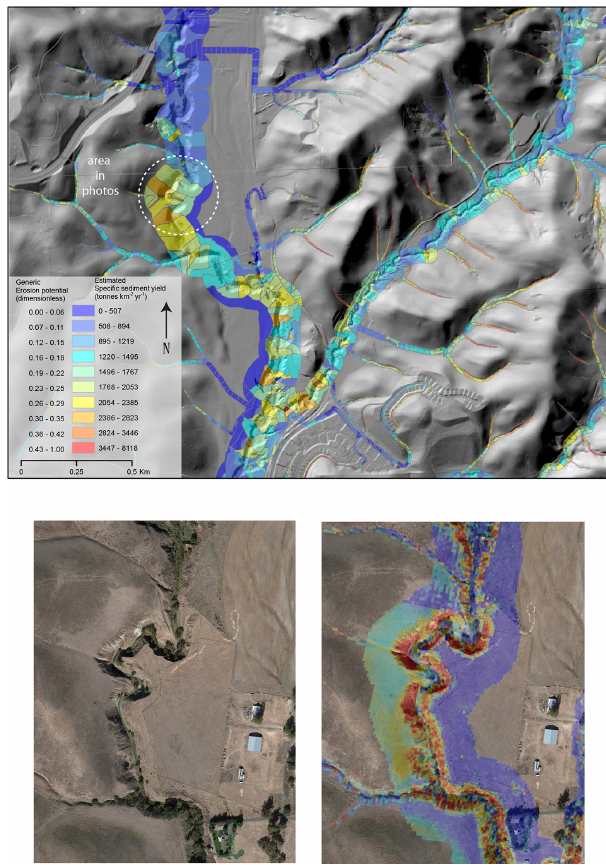
Figure 5. Incised channel on lower Tassajara Creek basin showing GEP and estimated specific sediment yield at the reach scale (upper) and air photo (lower left) with pixel scale GEP draped over image (lower right).